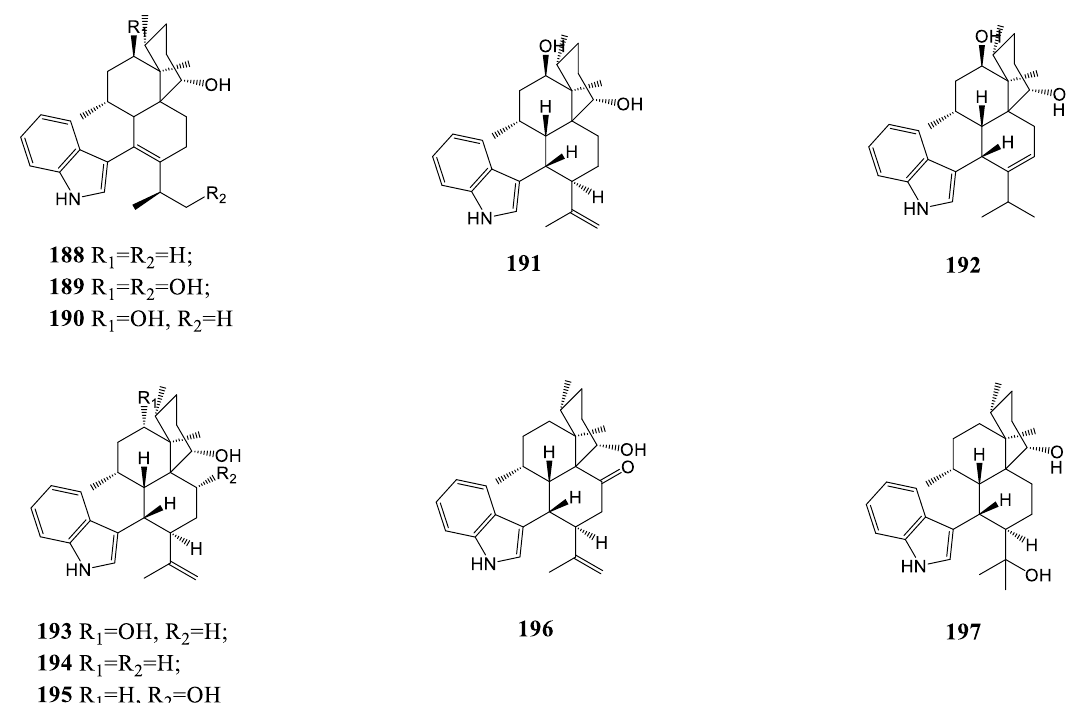
Figure 9. Alfavinine and its derivatives.